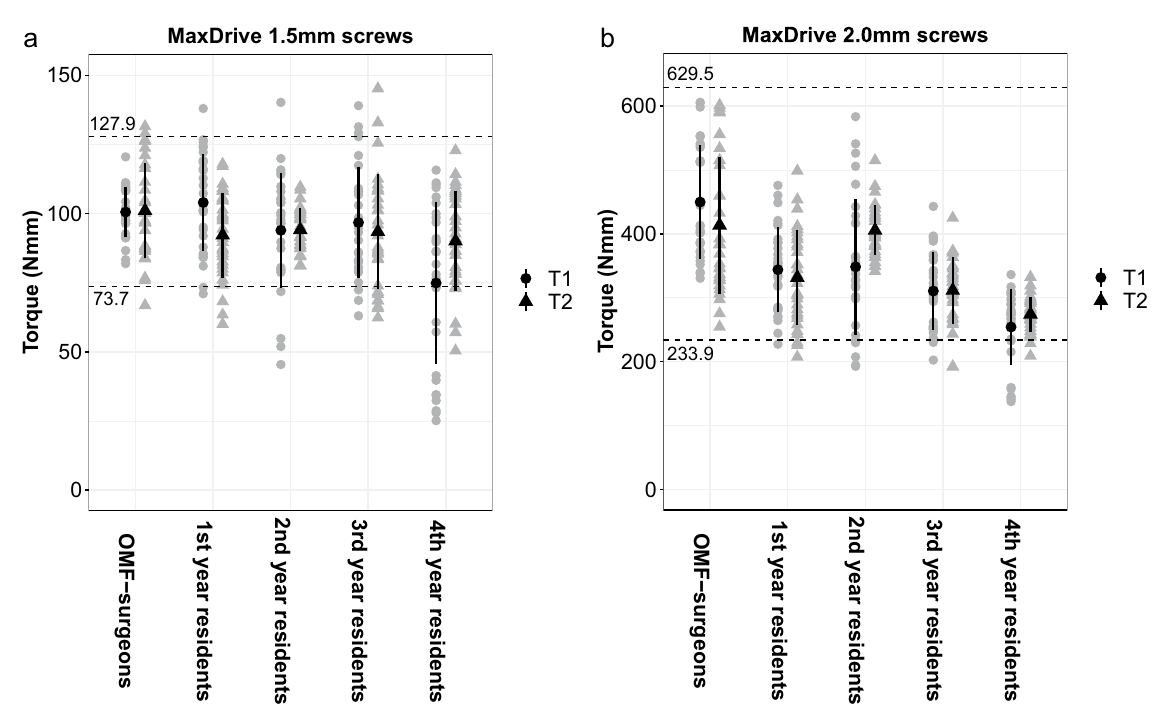
Figure 3. The applied torque to ( a ) 1.5 mm and ( b ) 2.0 mm osteosynthesis screws at T1 and T2. The dotted lines represent the limits of the calculated reference intervals based on the outcomes of the OMF-surgeons accompanied by the corresponding values. Black dots and triangles represent mean values at T1 and T2, respectively, with corresponding standard deviations. OMF oral and maxillofacial, T 1 at baseline, T 2 after 2